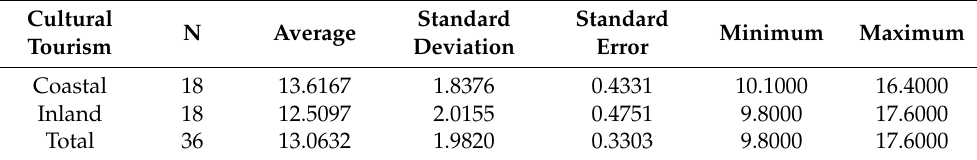
Table 4. Descriptive statistics for the ACs of the French Way: coastal (Galicia) and